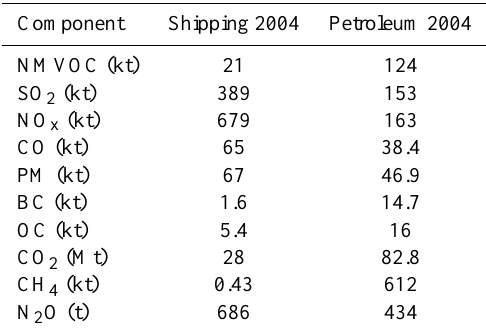
Table 1. Emissions from shipping and petroleum activity in the Arctic in 2004 (values are in kt-NMVOC, kt-SO 2 , kt-NO 2 ,